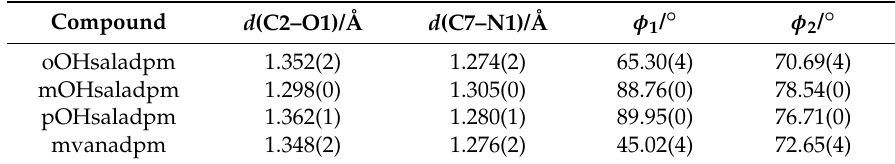
Table B3. Hydrogen bond geometry (Å, °) in compound oOHsaladpm . D , donor atom; A , acceptor atom.